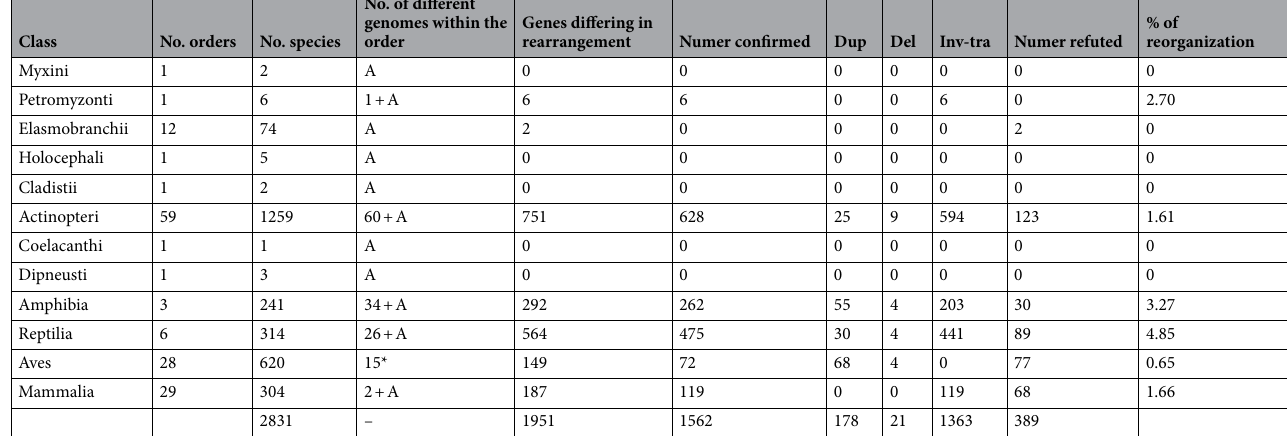
Table 1. Number and distribution of analyzed mitochondrial genomes with summary of types of deletions, duplications, inversions, translocations that have been reported in GenBank correctly or as errors. Taxa includes taxonomic classes analyzed without reorganizations: Myxini, Elasmobranchii, Holocephali, Cladistii, Coelacanthi and Dipneusti. Dupli. duplications, Dele. deletions, Inver. inversions, Trans. translocations.